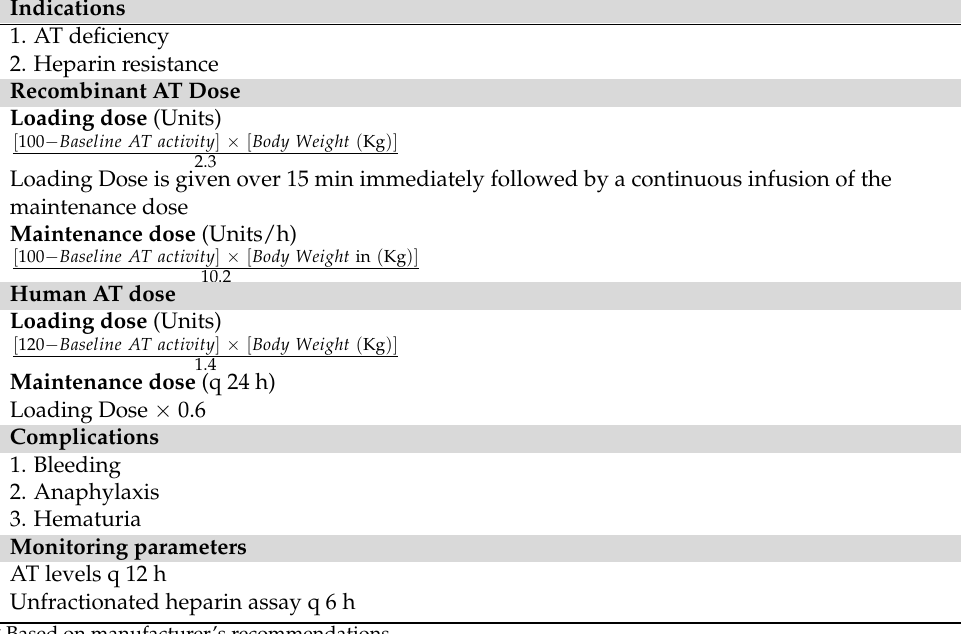
Table 2. Recombinant Antithrombin (AT) dose adjustment *. Initial Monitoring Time AT Level Dose Adjustment Recheck AT Level 2 h after initiation of